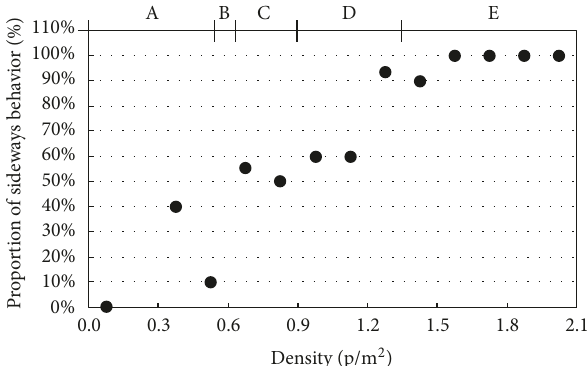
Figure 13: Proportion of sideways pedestrian evasive behavior with the increase of